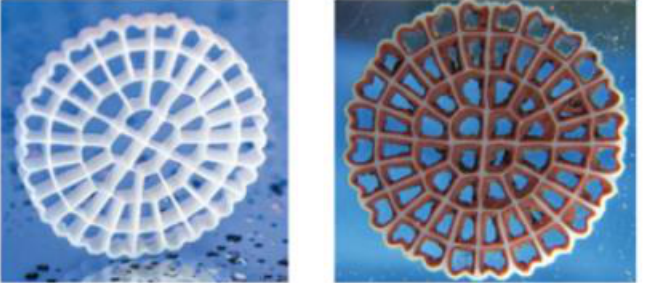
Figure 1. Virgin AnoxK TM 5 and AnoxK TM 5 with biofilm.